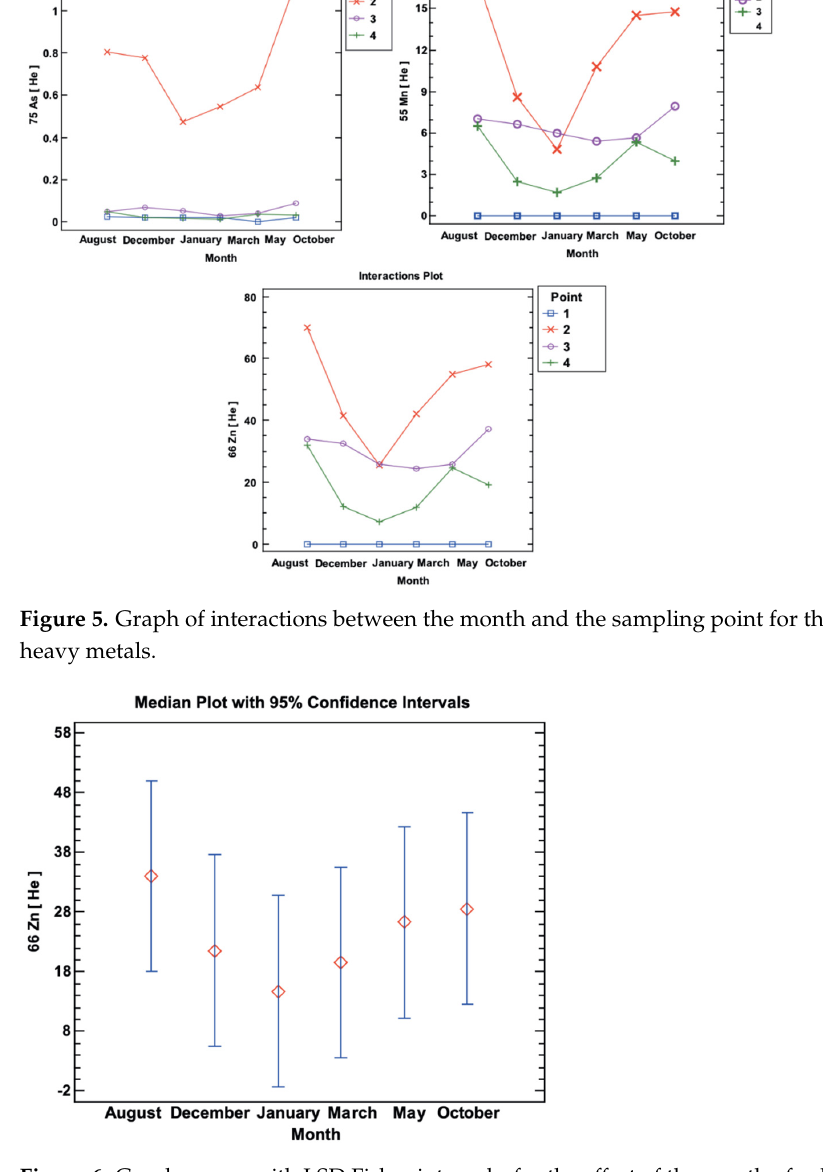
Figure 6. Graph means with LSD Fisher intervals, for the effect of the month of collection of samples with the concentration of zinc (Zn). Table 2. ANOVA table for Zn concentration as a function of collection point